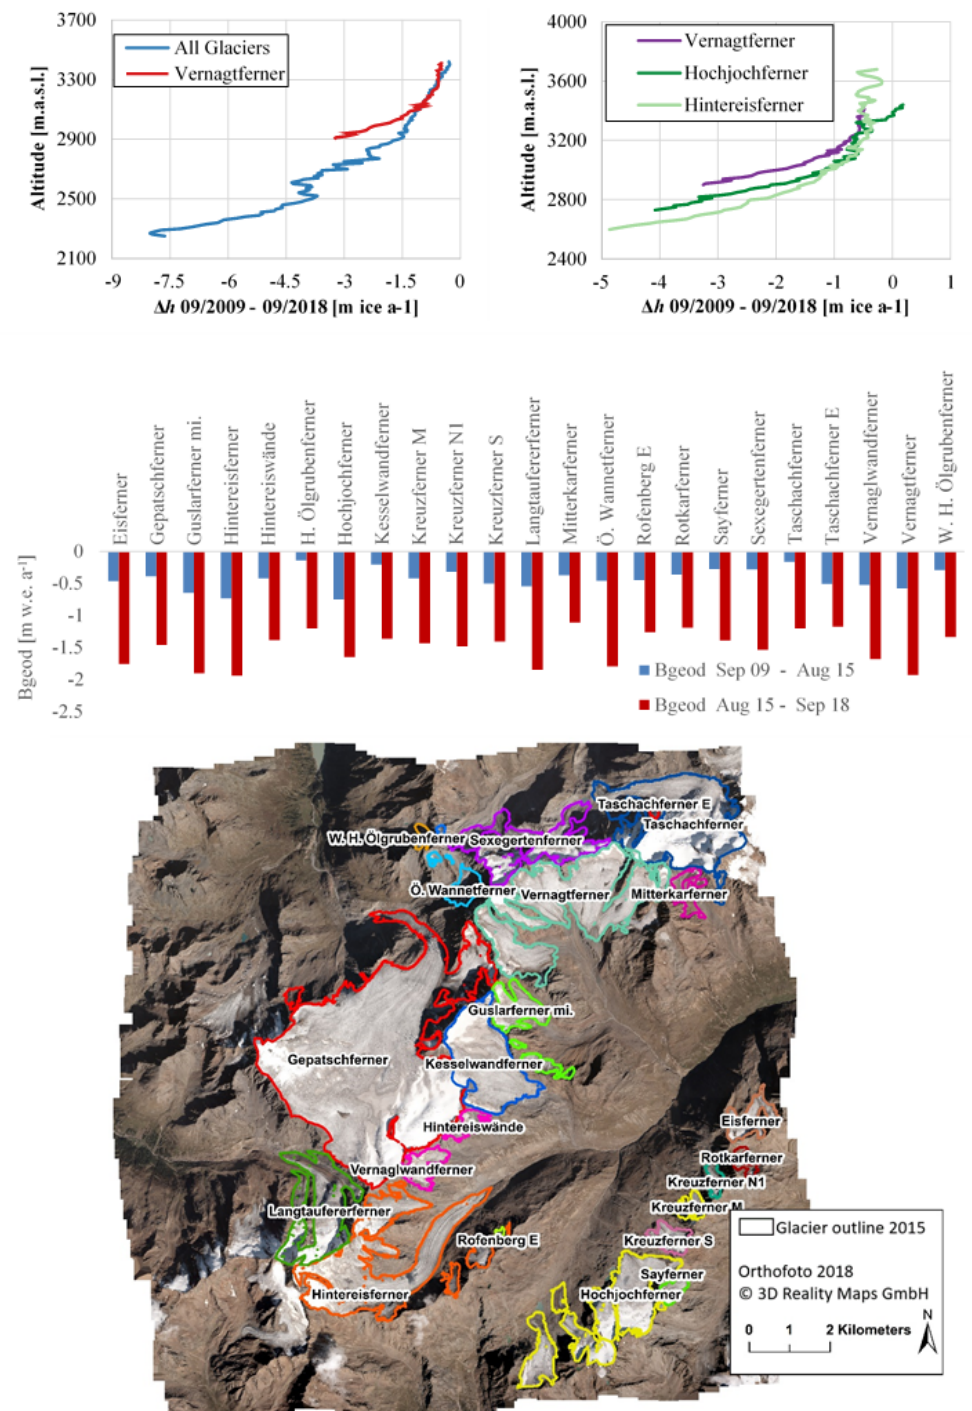
Figure 11. Annual height changes per altitude between September 2009 and September 2018 for the Vernagtferner compared to (i) all glaciers within the study area (top left) and (ii) the Hochjochferner and Hintereisferner (top right); comparison of temporally uncorrected geodetic mass balances (Bgeod) of all glaciers within the study area for the two investigation periods (middle); glacier outlines of 2015 are shown on orthophoto 2018